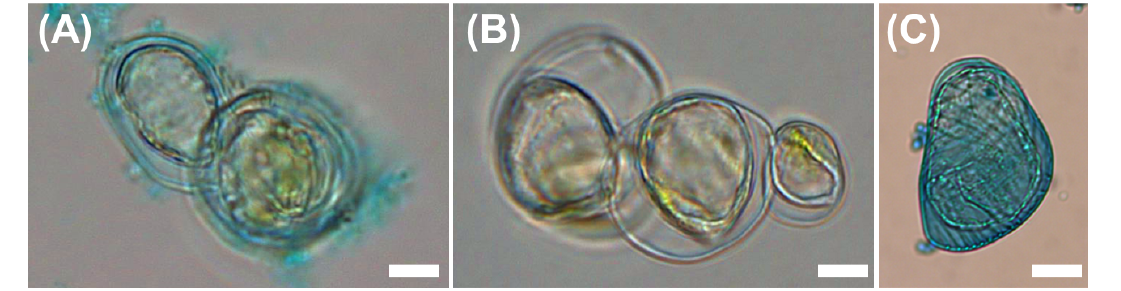
Figure A4. Transmitted light images of VND7-inducible cells immersed in sorbitol solution for 1 min visualizing the immediate effects of plasmolyzing conditions. Cytoplasm retraction upon plasmolysis is observed for cells at ( A ) stage 0, ( B ) stage 1, ( C ) stage 2. All scale bars 20 µ